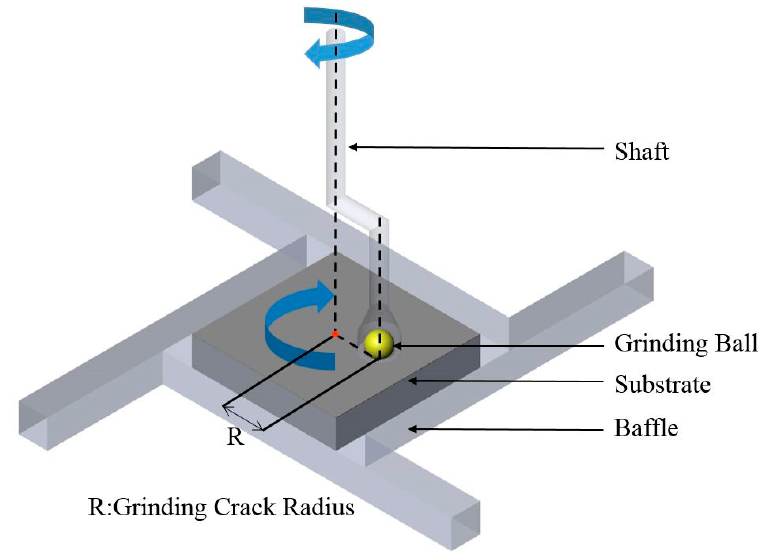
Figure 3. Schematic diagram of friction and wear experiment.